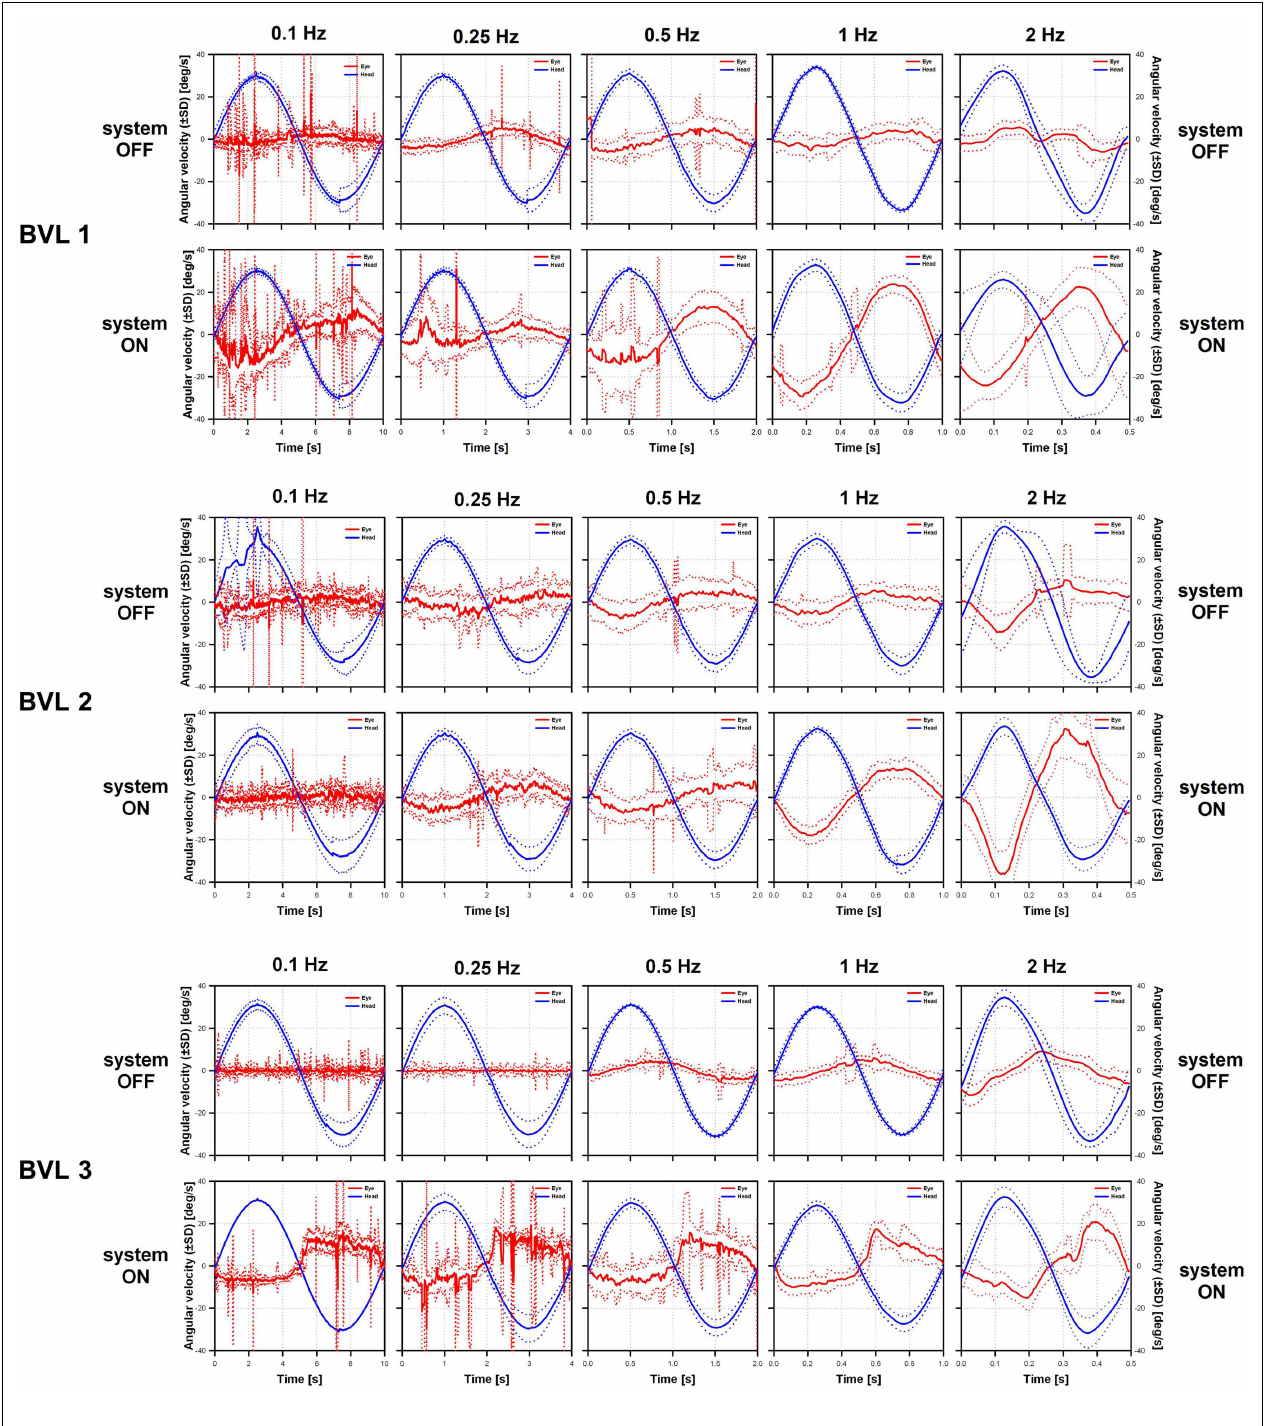
condition. Solid lines represent the average cycle plots ( ± standard deviation, SD shown in dotted lines) of the horizontal angular velocity of the eye (red lines) and the head (blue lines). Note that at the lower frequencies eye movement recordings were polluted by random artifacts mainly due to the long duration of cycles at these frequencies (e.g., 10s for 0.1Hz